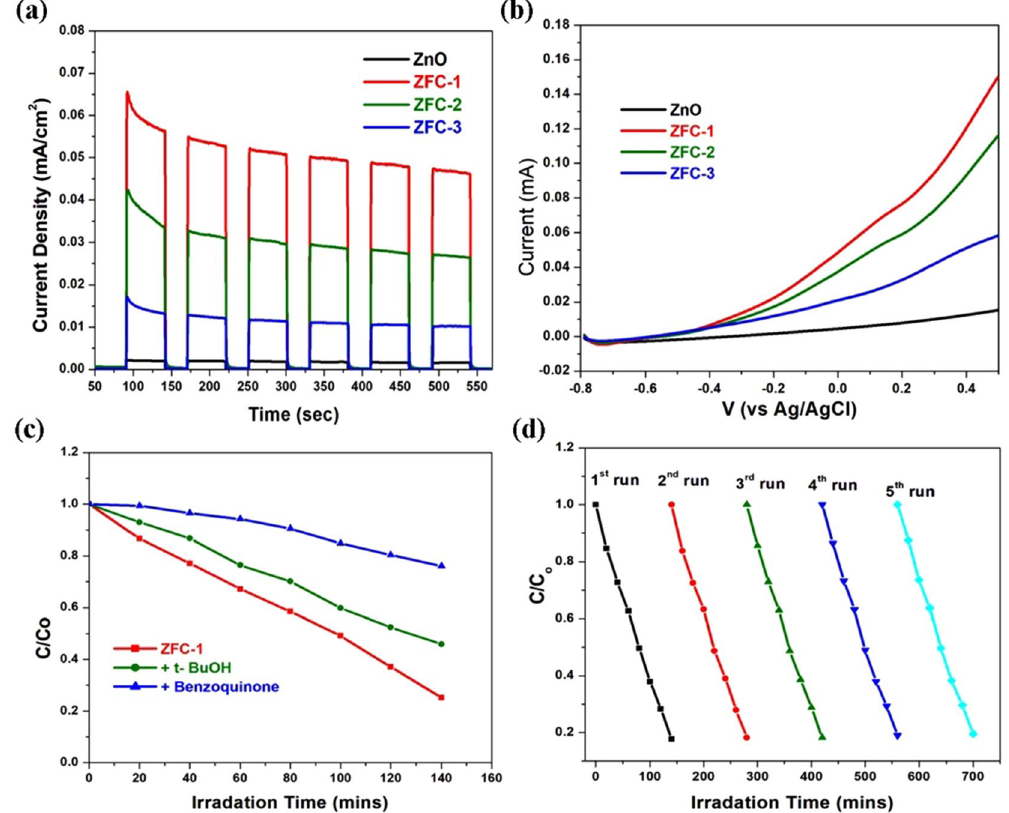
Figure 5. ( a ) Surface photocurrent, ( b ) Linear sweep volumetric (LSV) spectra, ( c ) Influence of t-BuOH and benzoquinone used as ·OH and ·O 2 − scavengers, respectively, on the photocatalytic activity of ZFC-1, and ( d ) Reusability of ZFC-1 for the cyclic degradation with initial concentration of RhB